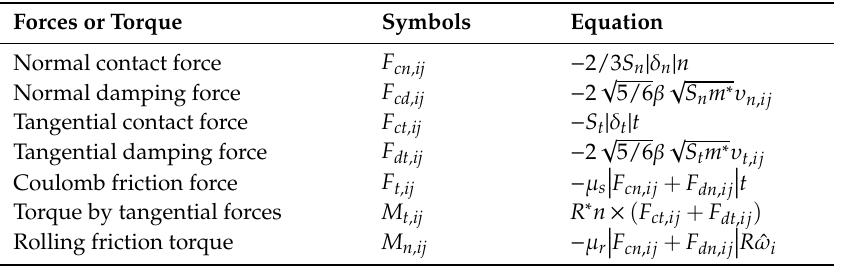
Table A1. Forces and torques acting on particle i